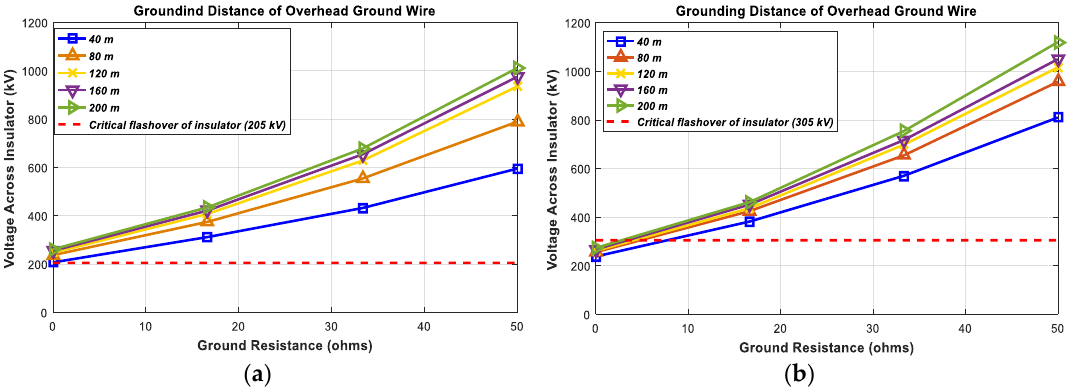
Figure 10. Voltage across the insulator resulting from a lightning strike to the overhead ground wire (lightning current wave shape = 4.12/77.5 μs, lightning current = 40 kA); ( a ) Strike to the middle of the overhead ground wire; ( b ) Strike to the end of the overhead ground wire. (B) Effect of the front and tail time of the lightning current wave shape on the voltage across the insulator